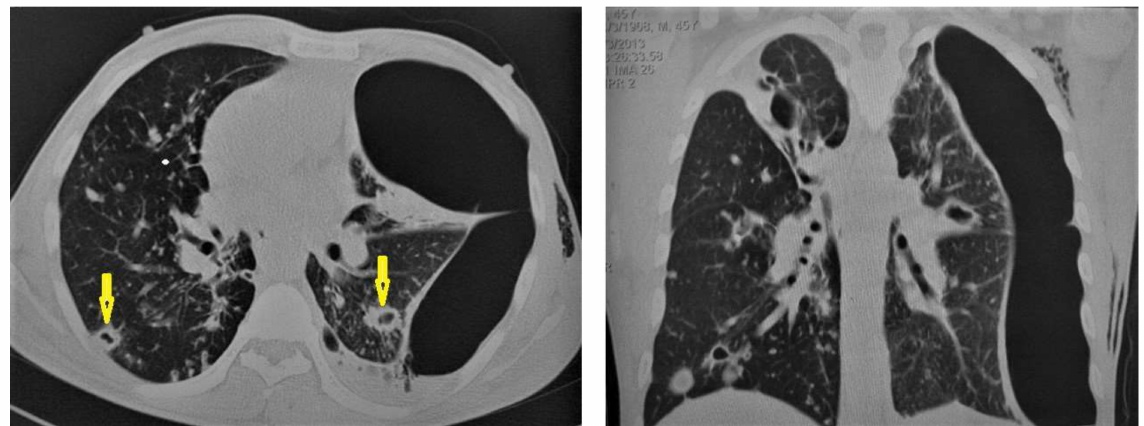
Figure 11. Post-primary-TB in a 45-year-old man. Selected axial and coronal reconstruction images of chest CT show multiple thick-walled cavitary lesions (arrows) in both lungs, with left pneumothorax as a complication of TB. Surgical emphysema in the left chest wall, due to chest-tube